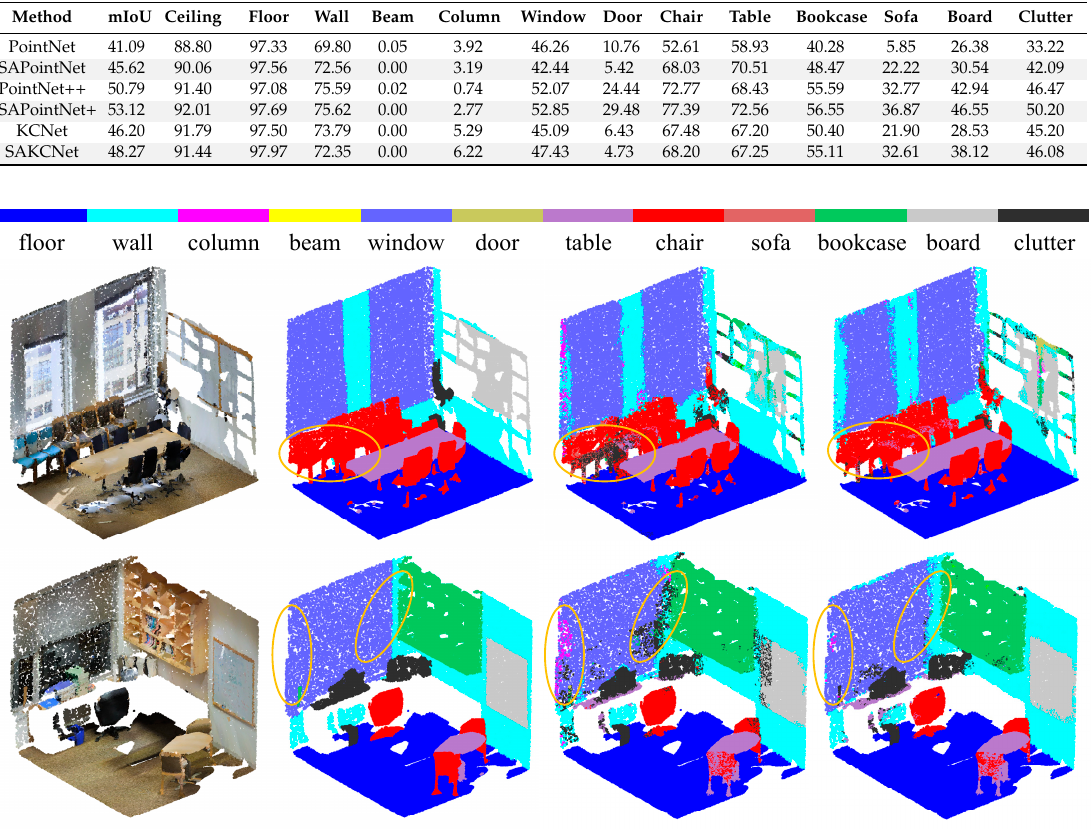
Figure 7. Illustration of the mobile laser scanning (MLS) point clouds from Wuhan University (WHU). P1 and P2 are the training and testing datasets, respectively.